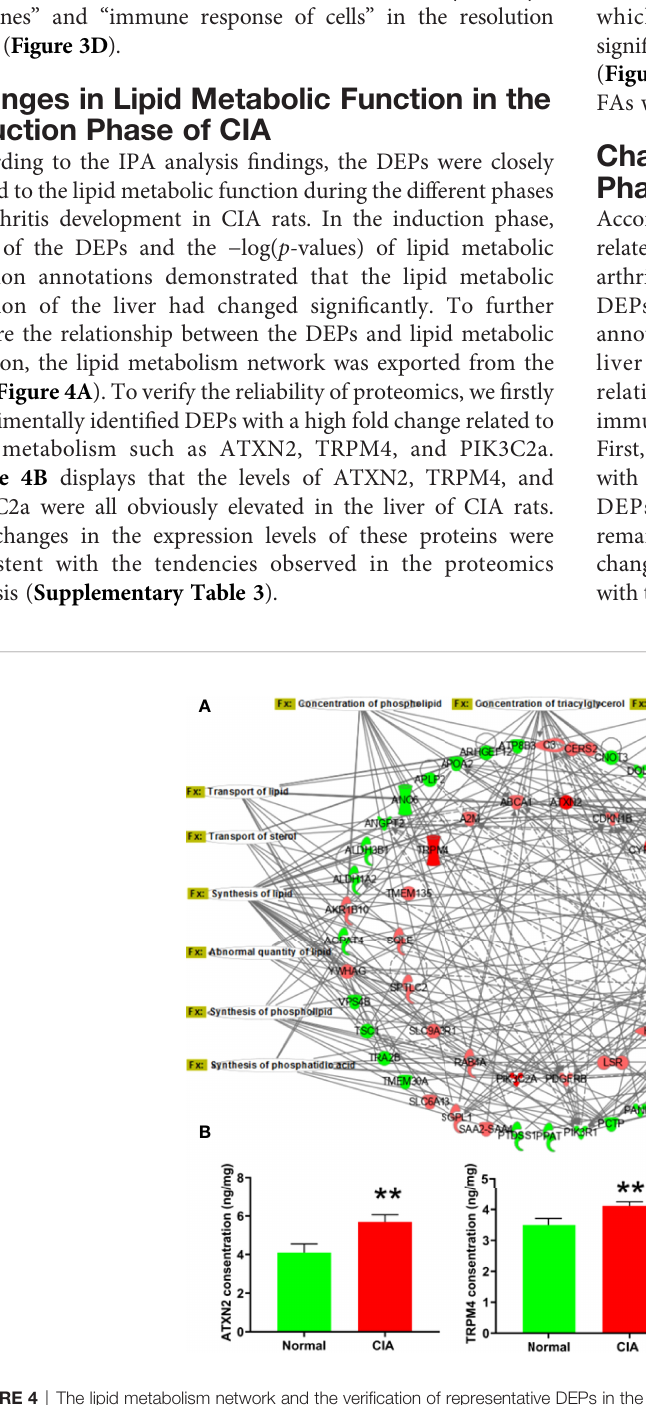
FIGURE 4 | The lipid metabolism network and the veri fi cation of representative DEPs in the induction phase. (A) The lipid metabolism network: the red color represented the upregulation of protein expression in the model group vs. the normal group and the green color represented the downregulation of protein expression in the model group vs. the normal group. (B) The veri fi cation of DEPs related to lipid metabolism. Data were expressed as mean ± SD. N = 6. ** p < 0.01 compared with the normal